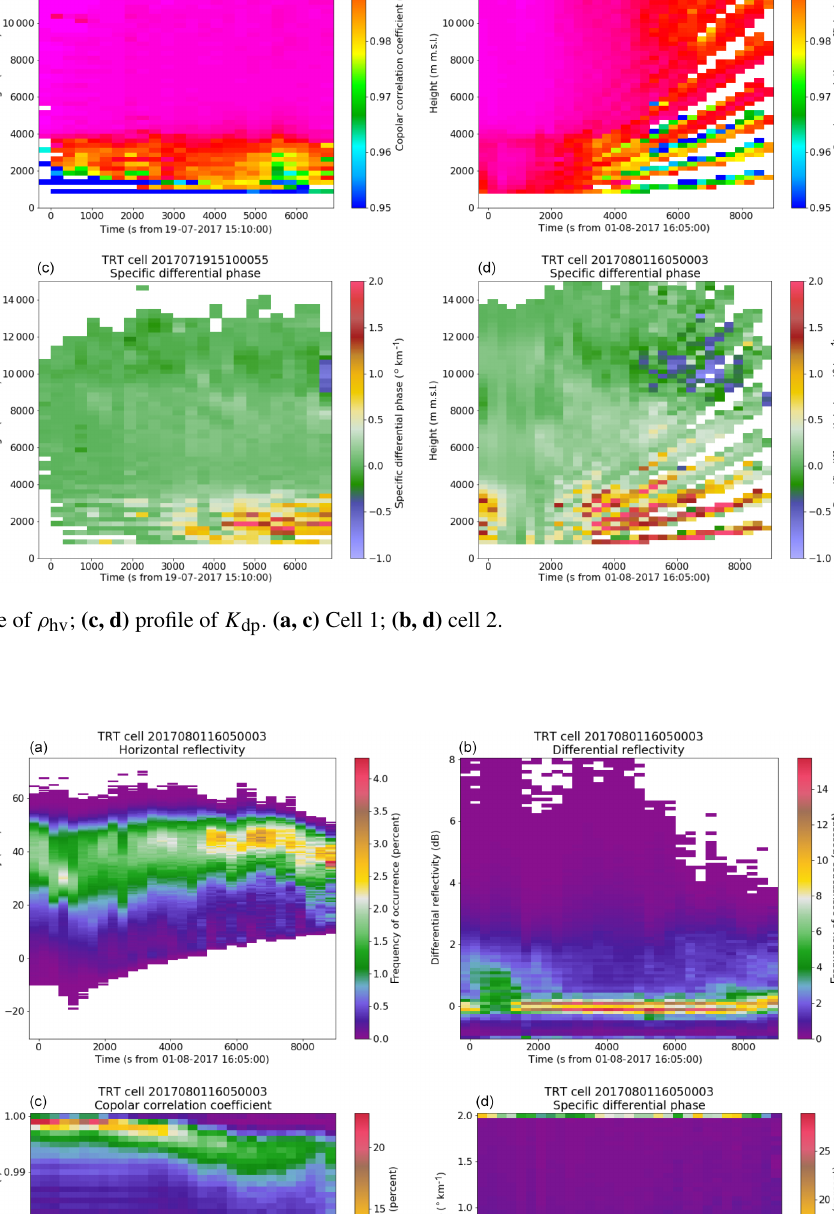
www.atmos-meas-tech.net/12/5573/2019/ Atmos. Meas. Tech., 12, 5573–5591,